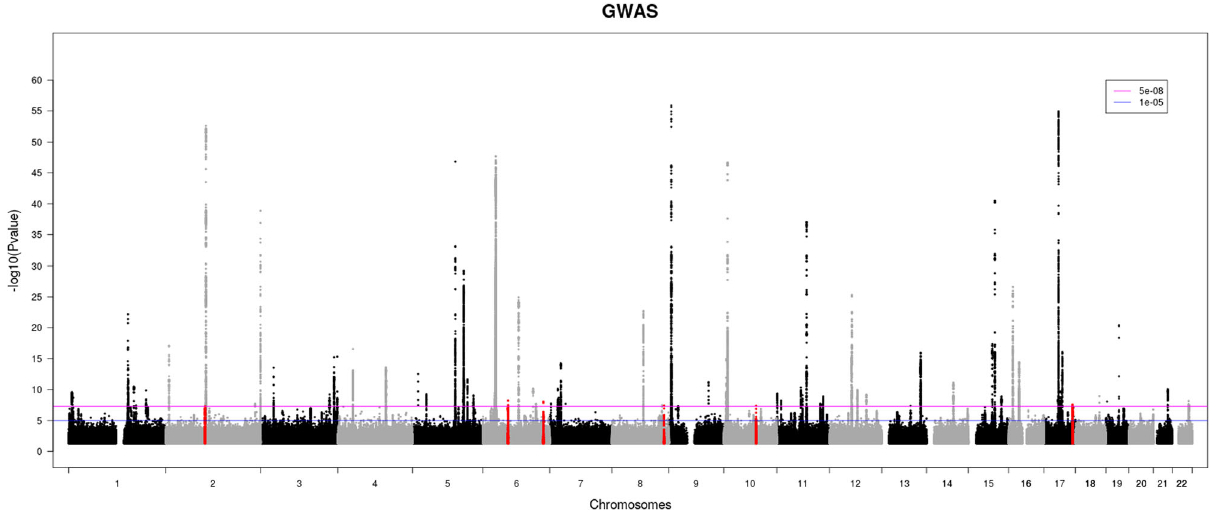
Fig. 1 Manhattan plot of the GWAS on asthma in UK Biobank. The GWAS was performed in 56,167 asthma cases and 352,255 controls. The y axis represents P value in − log10 scale. The horizontal blue and magenta lines indicate P value of 1 × 10 − 5 and 5 × 10 − 8 , respectively. Novel asthma loci are in red. Genetic variants with P value > 0.05 were removed to limit the digital information of the